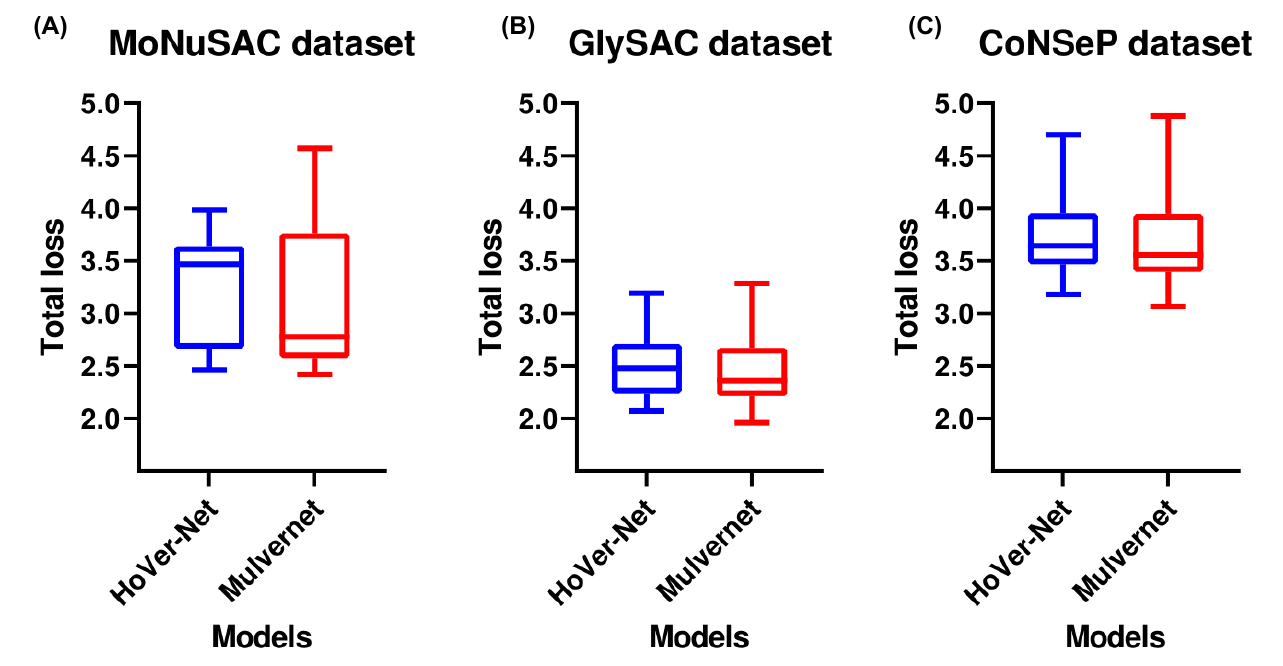
Figure 6. The comparison of total loss in the validation set of three datasets between original HoVer- Net and Mulvernet. ( A ) The comparison on MoNuSAC dataset. ( B ) The comparison on GlySAC dataset. ( C ) The comparison on CoNSeP